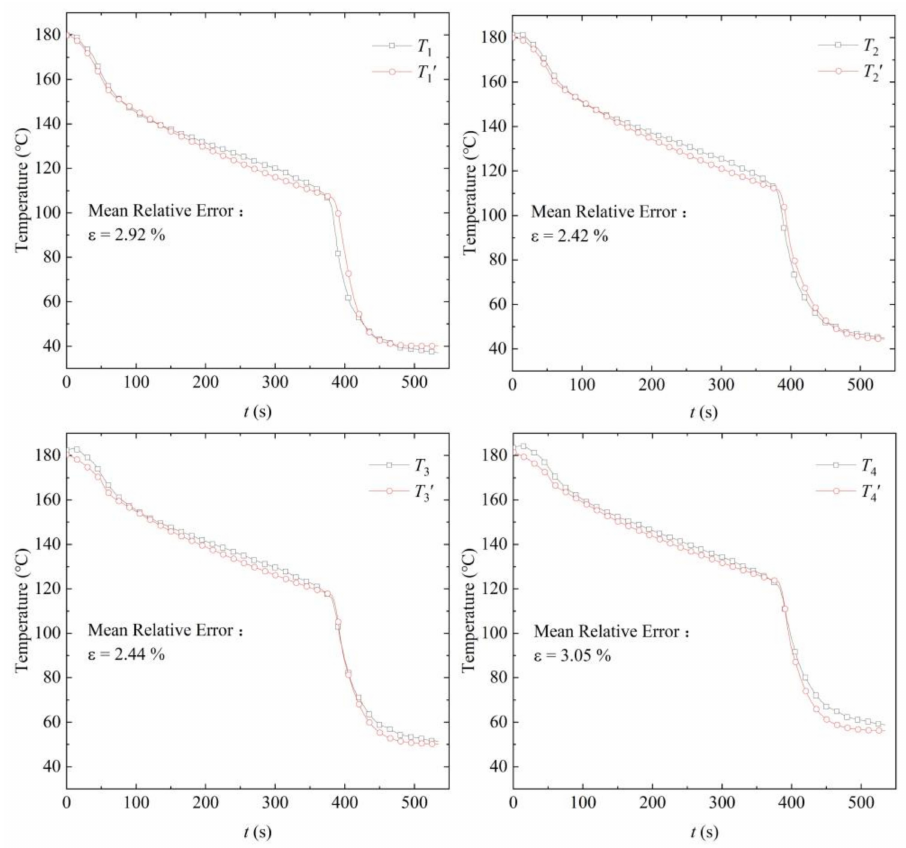
Figure 5. Comparison of the IHCP and the actual